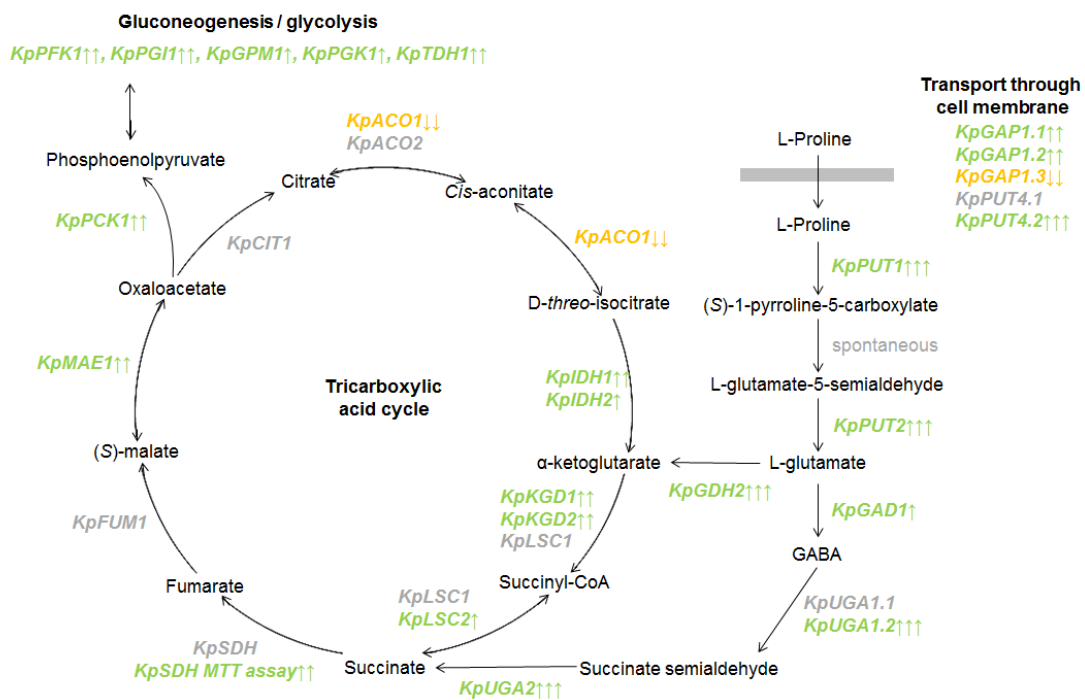
Figure 3. Scheme representing proline oxidation, gamma-aminobutyric acid (GABA) shunt and tricarboxylic acid (TCA) (based on data known for S. cerevisiae ). Genes are placed near the reactions catalyzed by the correspondent proteins. Genes that are repressed in media with proline are marked in orange. Genes that are activated in media with proline are marked in green. Genes that do not change their expression are marked in grey. The number of arrows represent values of log2FoldChange parameter. One arrow: 0.5 < log2FoldChange < 1; two arrows: 1 < log2FoldChange < 2; three arrows: 2 < log2FoldChange.